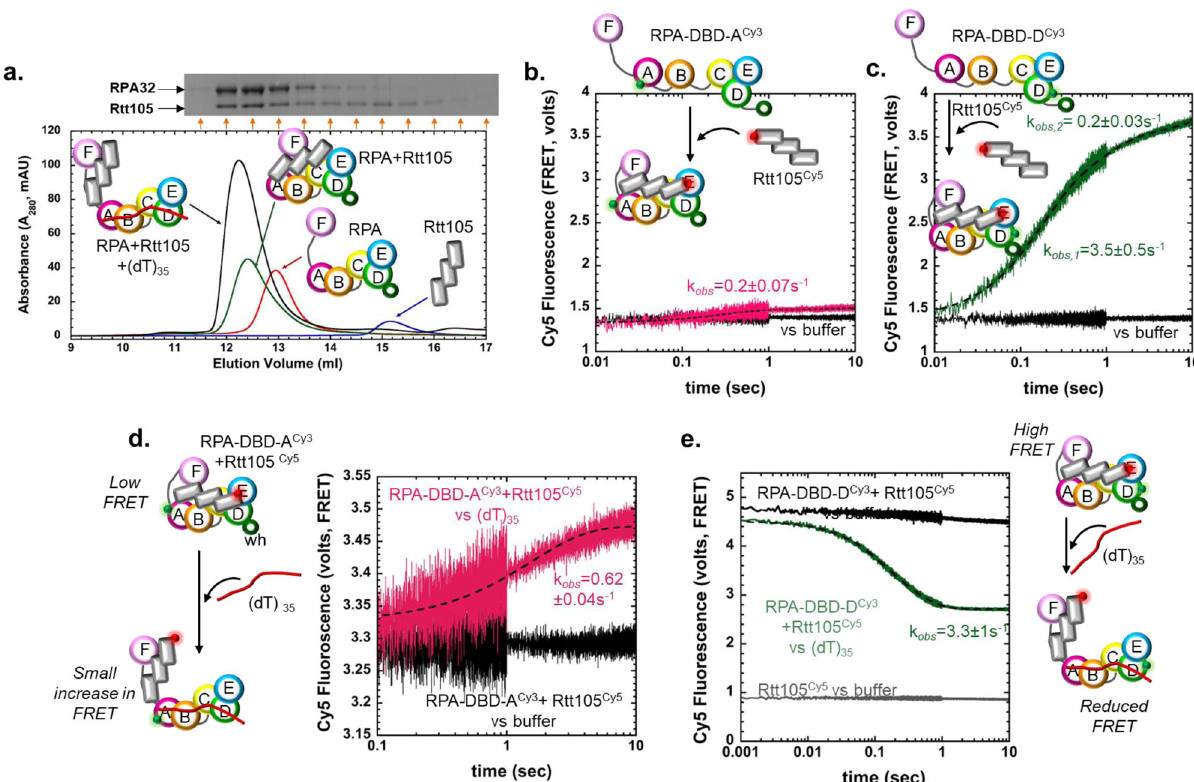
Fig. 3 | Rtt105 forms a higher order complex with RPA bound to short ssDNA substrates. a Size exclusion chromatography (SEC) analysis of Rtt105, RPA, and Rtt105-RPA show complexformation between the proteins. Addition of equimolar amounts of (dT) 35 drive formation of a higher order Rtt105-RPA-(dT) 35 complex. SDS page analysis of the SEC fractions (insert) shows RPA and Rtt105 comigrating as a complex in the presence of DNA. A small fraction of free Rtt105 is also observed. b The kinetics of RPA binding to Rtt105 was measured using FRET with Cy5-labeled Rtt105 and either RPA-DBD-A Cy3 or c RPA-DBD-D Cy3 . Cy3 positioned on DBD-D produces a larger FRET-induced Cy5 enhancement compared to DBD-A suggestingthattheN-terminalregionofRtt105residesclosertoDBD-DofRPA.The dataforRPA-DBD-Ain b fi tswelltoasingleexponentialmodel(k obs =0.2±0.07s − 1 ) whereas the RPA-DBD-D data is better described by a double exponential (k obs,1 =